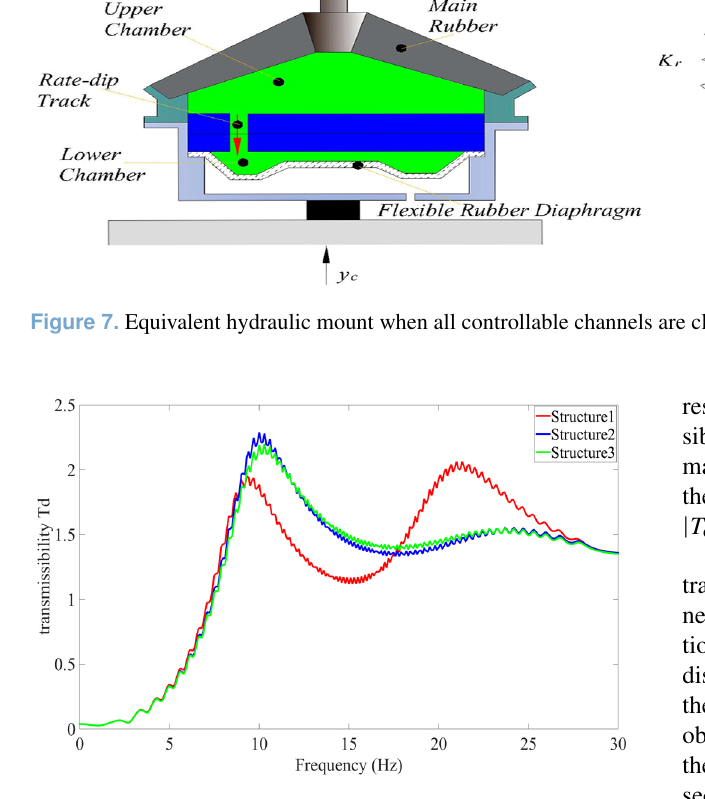
Figure 8. Relative displacement transmissibility of the three struc- tures.